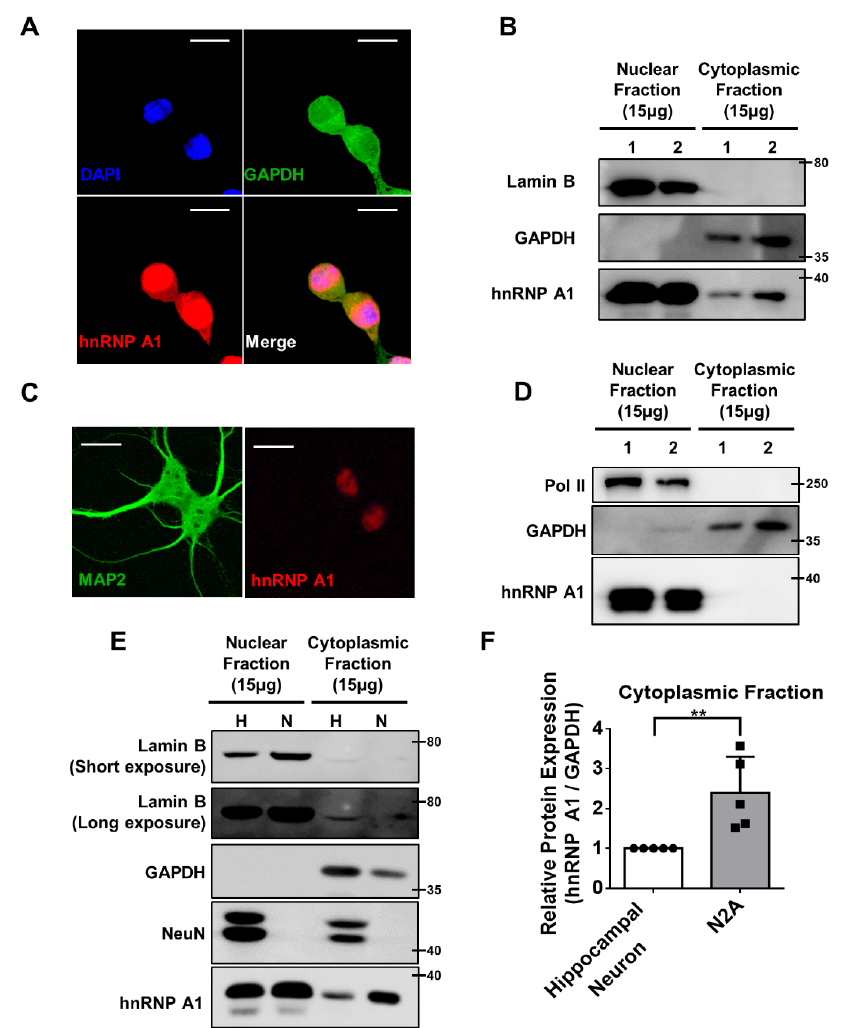
the immunofluorescence labeling of hnRNP A1 (magenta) and Tau (green), along with RNA fluorescence in situ hybridization (RNA FISH) of Cfl1 mRNA (white) using Stellaris™ RNA FISH. The co-localization of hnRNP A1 and Cfl1 mRNA in the soma (1A) and axon (2A) of the neurons is shown through scaled-up images. Scale bar = 30 µ M. ( G ) Quantification of co-localization between Cfl1 mRNA and hnRNP Q (blue) or hnRNP A1 (orange) from experiments in ( E , F ), measured by the percentage of co-localization (co-localized Cfl1 mRNA spot/total Cfl1 mRNA spot). *** p ≤ 0.001; unpaired Student’s t test ( n = 7). “ n ” represents the number of independent experiments. Data are represented as ± SD.